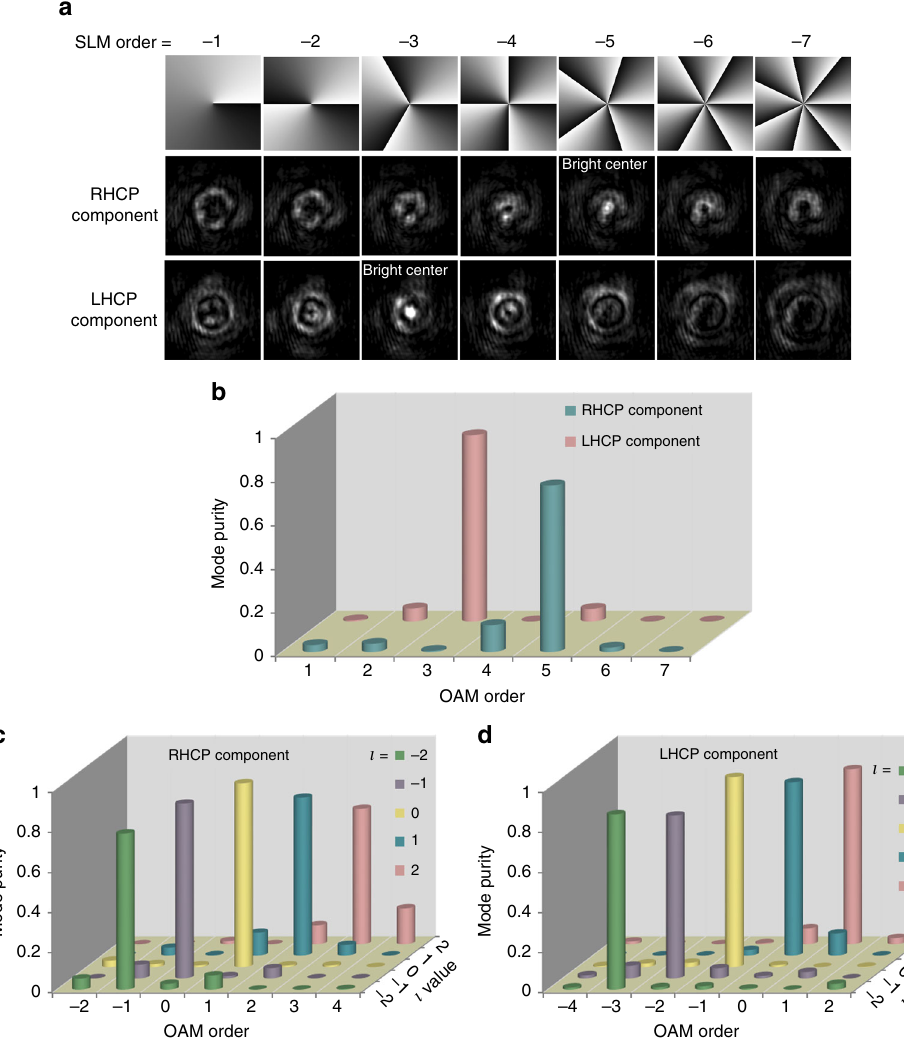
Fig. 4 OAM mode characterization. a OAM lasing modulated by SLM. The fi rst row shows holograms of the SLM. The second and third rows are patterns of the RHCP and LHCP components after being re fl ected by the SLM in the fi rst row, indicating l = + 4. b Mode purities of the OAM lasing measured by the SLM. c Mode purities of the RHCP and d LHCP components of the OAM-carrying beams radiated by the OAM